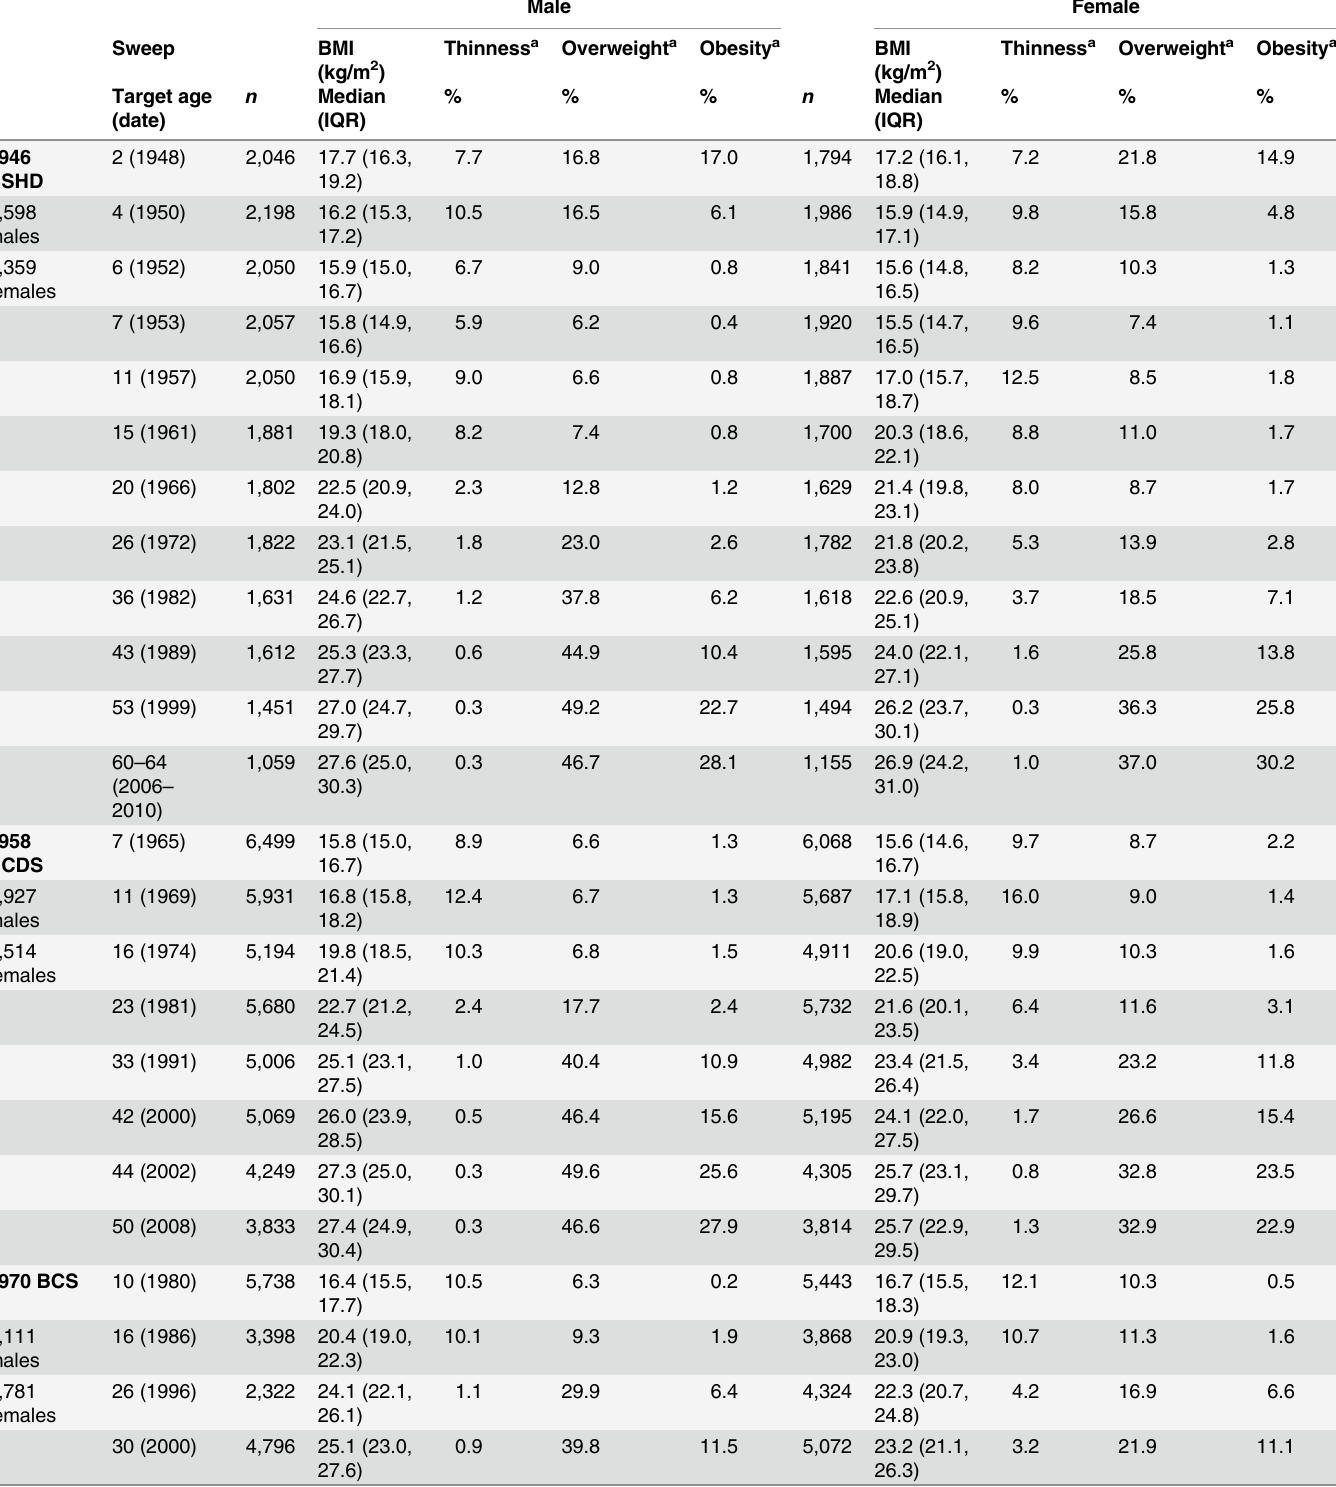
Table 1. Description of BMI data in the five UK birth cohort studies. Male Female Thinness a Overweight a Obesity a BMI Sweep BMI (kg/m 2 )